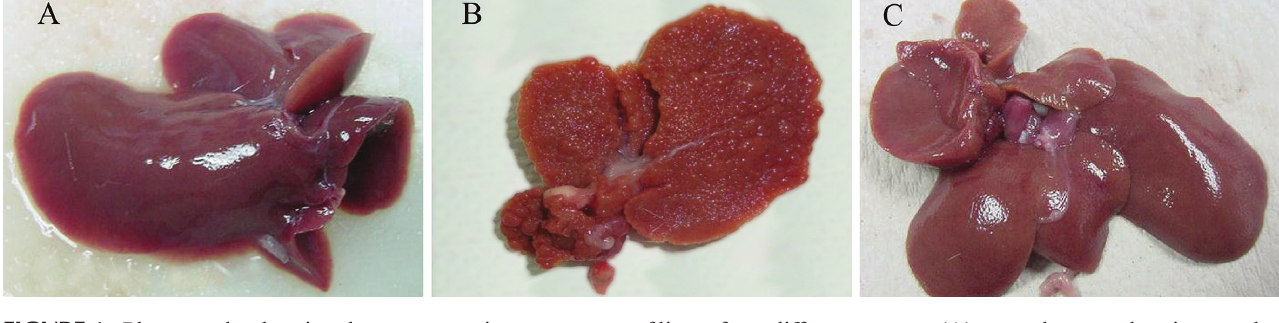
FIGURE 1 - Photographs showing the macroscopic appearances of livers from different groups: (A) control group-showing regular smooth surface, (B) TAA group-showing liver with multiple cirrhotic nodules on the whole surface of the liver, (C) TAA+Lesimarin- showing liver similar to normal with a smooth surface.